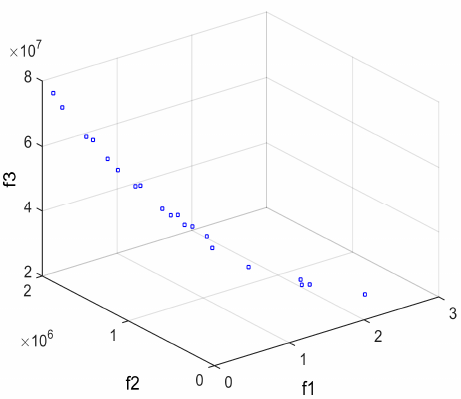
Figure 3. 20 representative alternatives obtained by k -means clustering. ( f 1 —square sum of relative water shortages; f 2 —water supply cost; f 3 —the amount of organic pollutants (COD) in water).